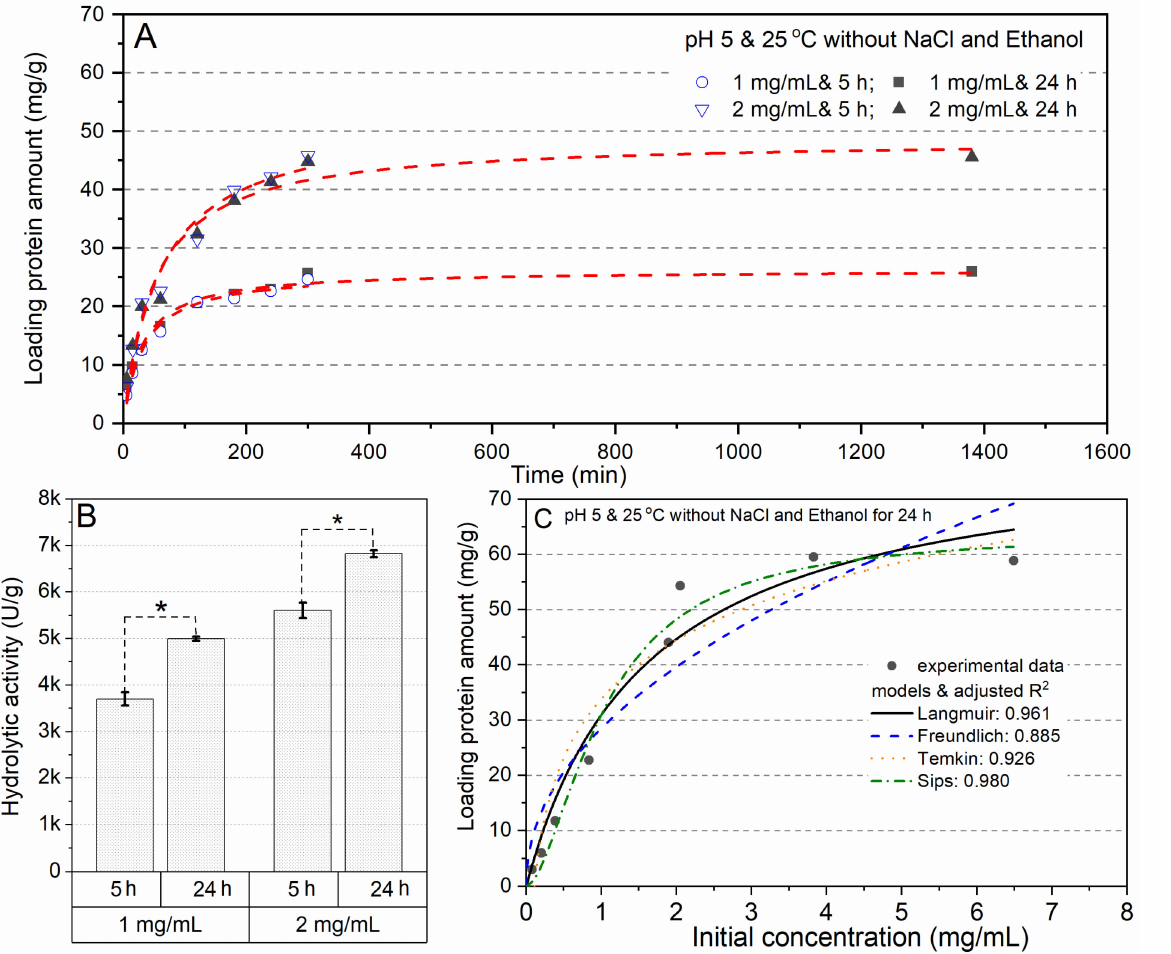
Figure 1. The adsorption kinetic of lipase at an initial protein concentration of 1 mg/mL or 2 mg/mL ( A ); the hydrolytic activity of immobilized lipases with different incubation times ( B ); non-linear isotherm models for the equilibrium data of lipase adsorption ( C ). * Indicates a significant difference (* p <